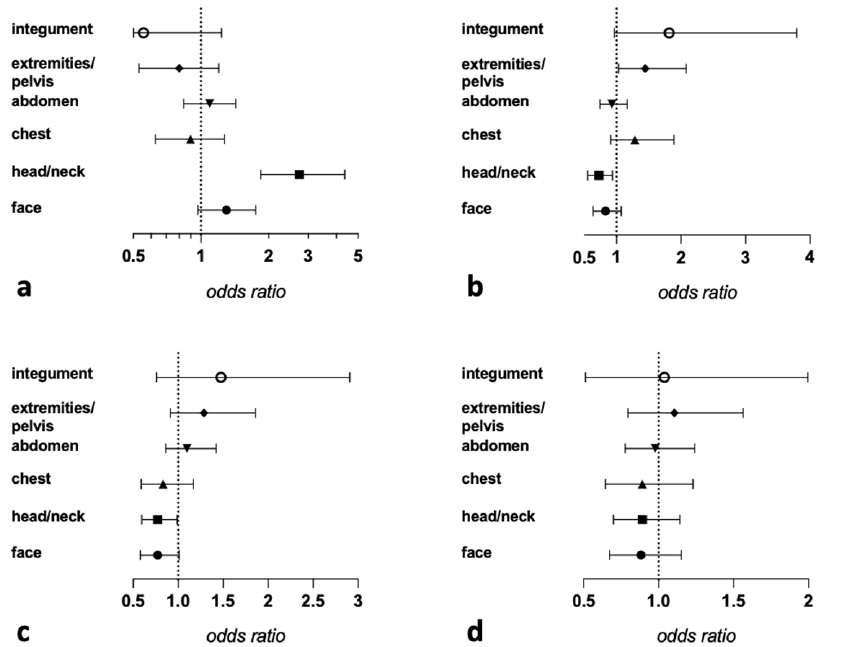
Figure 3. Coefplots (Odds ratios with 95% Wald confidence limits) for ( a ) CNS injury, ( b ) exsanguination, ( c ) airway compromise, ( d ) MOF. Most CI indicate no clear monodirectional relation between an increasing regional injury severity and a specific reason of